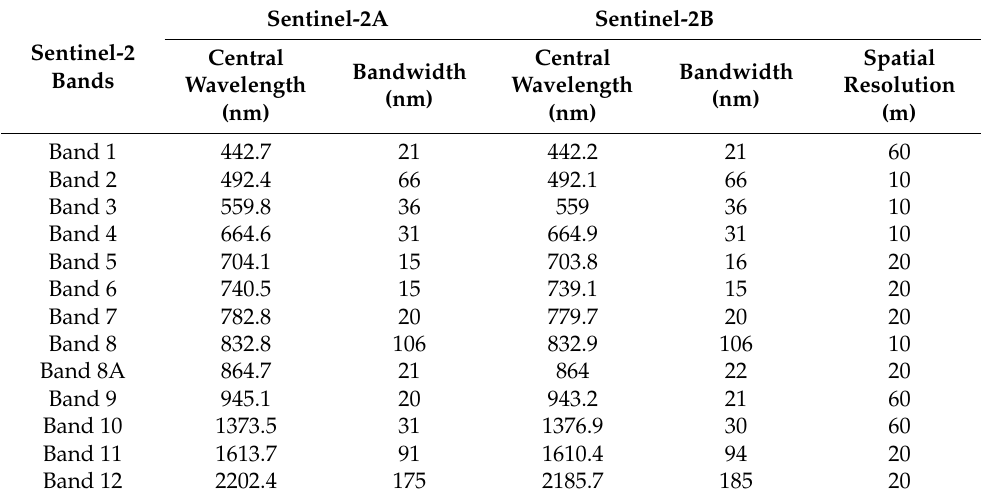
Table 1. The specification of the MSI spectral channels. Band 9 is useful for the total water vapor column estimation and band 10 is used for the detection of Cirrus clouds. Bands 1–8 are used in atmospheric correction procedures. Bands 11 and 12 can be used to distinguish cloud and clear sky snow